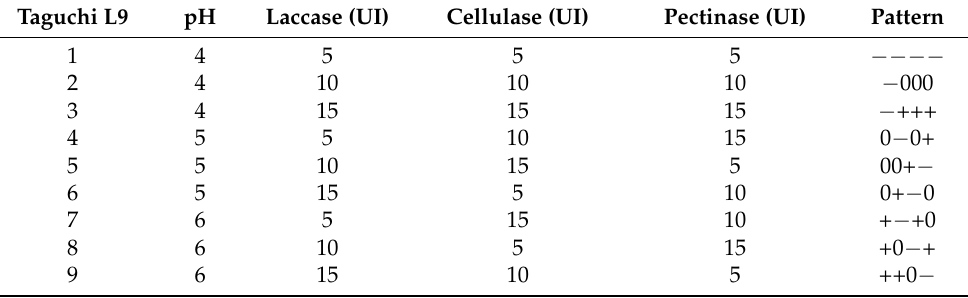
Table A1. Randomly generated Taguchi L9 orthogonal array for the experiment design with four variables and three factors: pH and concentrations of laccase, cellulase, and pectinase in IU. Taguchi